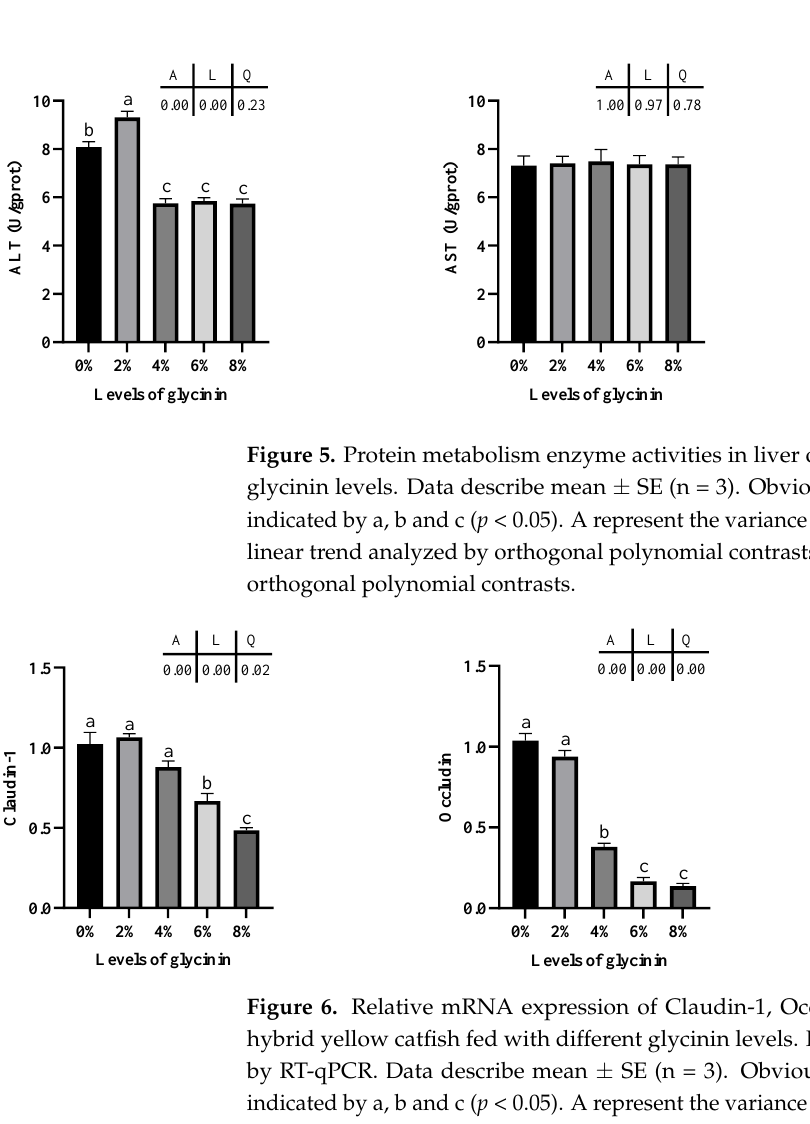
are shown in Figure 5. ALT activity linearly correlated with dietary glycinin levels and